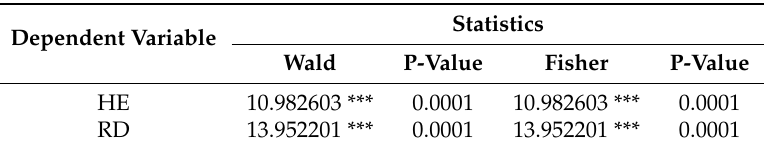
Table 7. Long-term Causality Statistics.